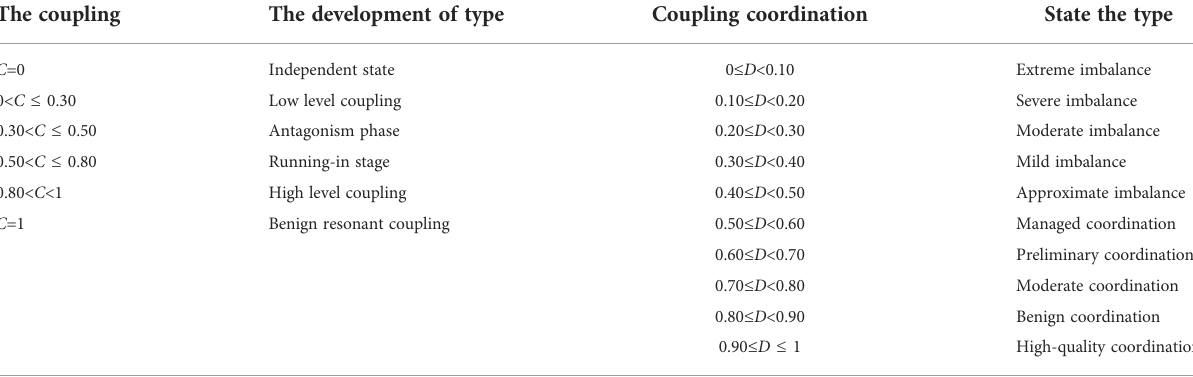
TABLE 2 Classi fi cation of the coupling degree and coupling coordination degree. The coupling The development of